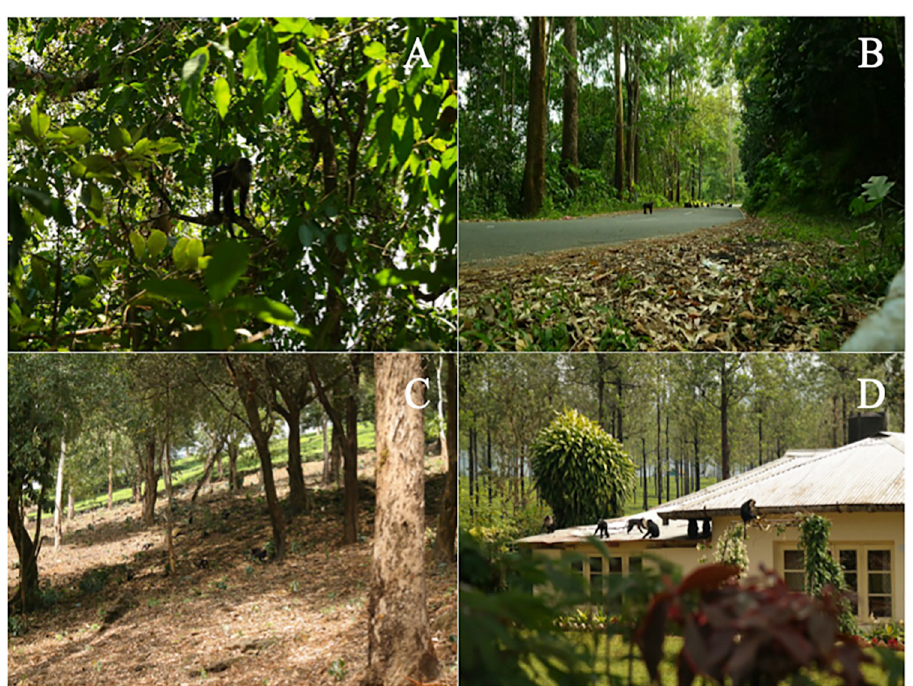
Fig 2. Habitat types present within the Puthuthottam forest fragment: Forest interior (A), Forest edge (B), Open forest patch (C) and human settlement (D).